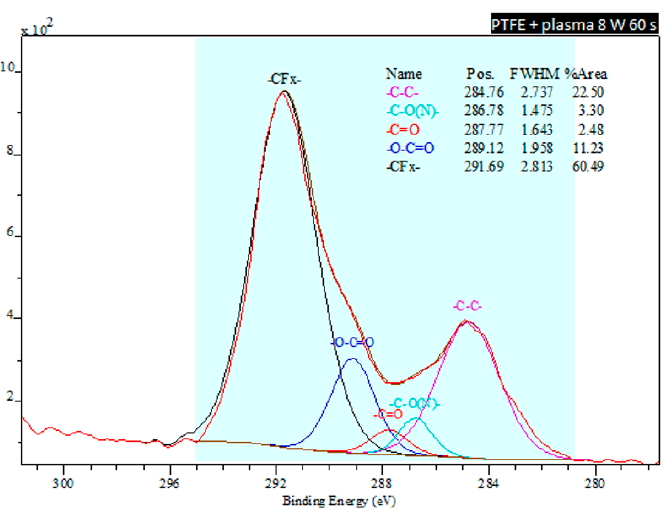
Figure 8. Deconvoluted spectra from an XPS analysis of a plasma-treated PTFE sample exposed to 8 W for 60 s.